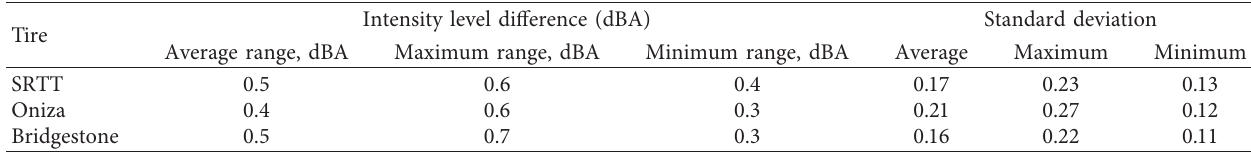
Table 2: Run-to-run variability at the start of each set of tire/vehicle